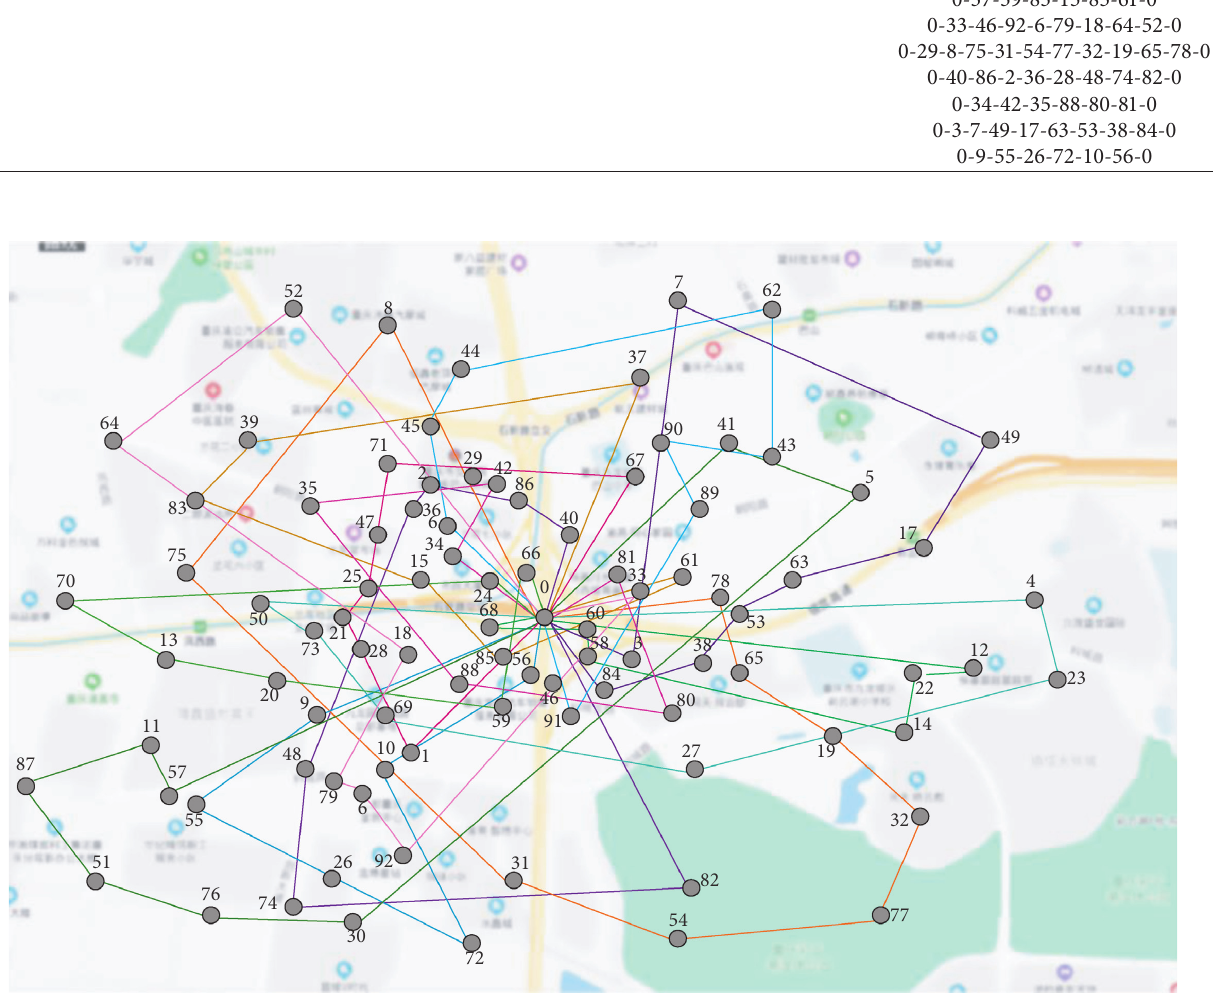
Figure 8: Visualization of the rider’s scheduling route.